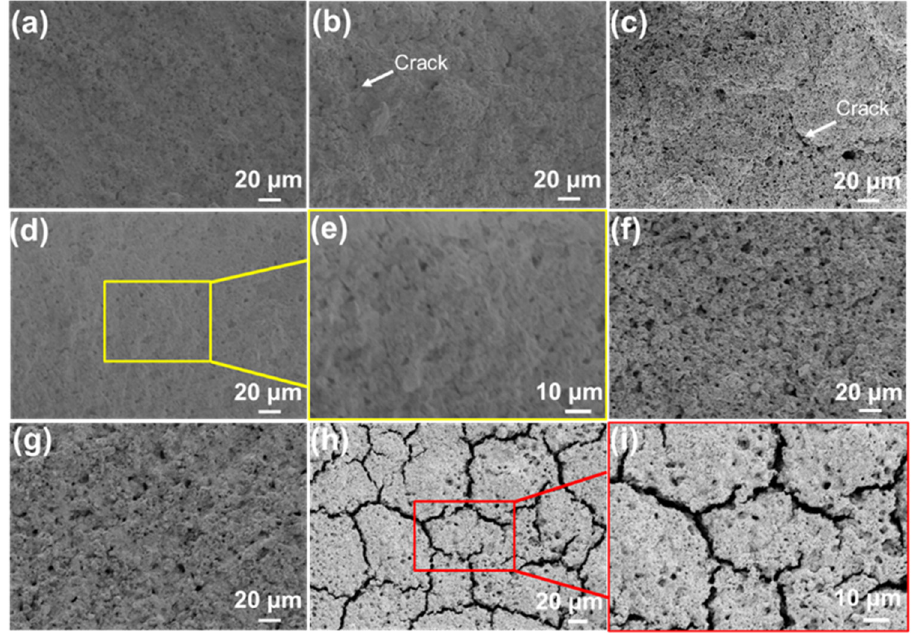
Figure 3. SEM images of the surface sections of the SiOC/Al 2 O 3 /YSZ coatings using YSZ filler (particle size 1 µ m) by changing the mass ratio of Al 2 O 3 and YSZ: ( a , b ) 0:1, ( c ) 2:3, ( d , e ) 1:1, ( f ) 3:2, ( g ) 7:3; and ( h , i ) using YSZ filler (particle size 50 nm) under the mass ratio of Al 2 O 3 and YSZ of 1:1. Spraying number: ( a ) 10 times, ( b ) 30 times, others 50 times.